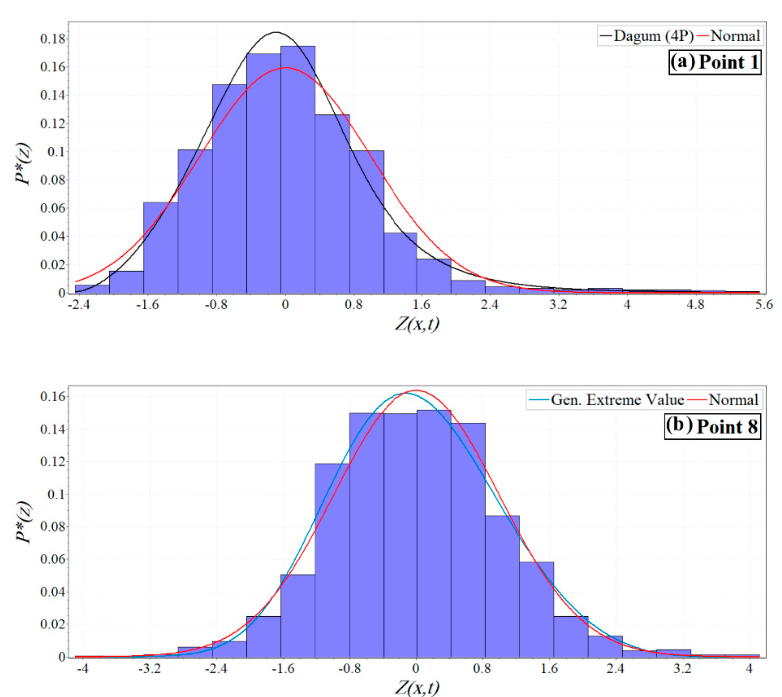
Figure 5. Figure 5. Cont . Figure 5. Cont .